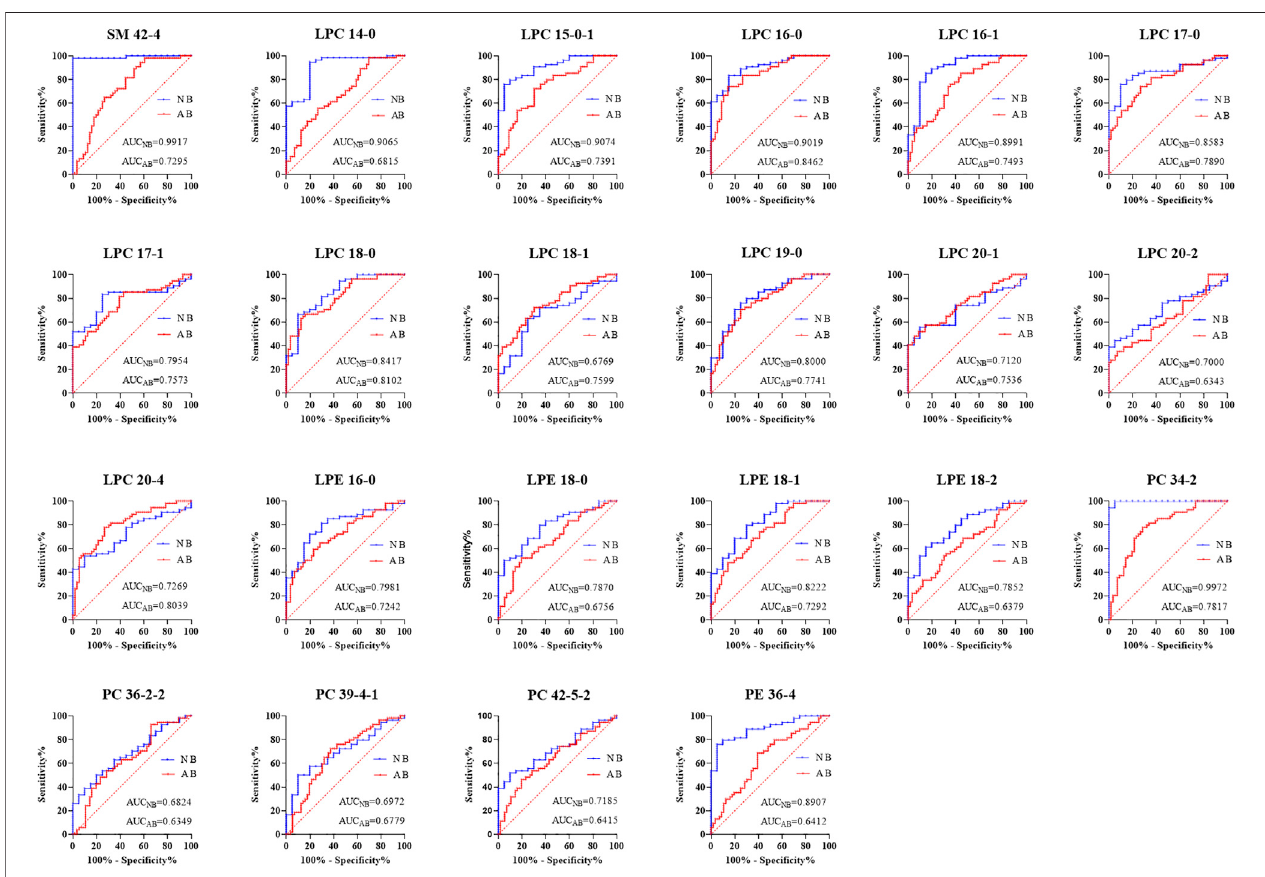
FIGURE 10 | The discriminatory ability between the healthy control group and the oral disease group, the oral disease group and the HLJDD intervention group were analyzed using an ROC curve (NB) Healthy control group and Oral disease group (AB) Oral disease group and HLJDD intervention group.